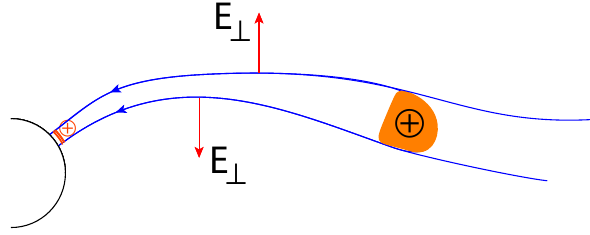
Fig. 5. A positive electromotive force in the outer magnetosphere enclosed between two field lines is experienced at all altitudes be- low it as an electric charge. The magnetic field lines behave as equipotentials thus mapping the electromotive difference between them down to the ionosphere where it possesses the same sign but acts like a positive space charge. This implies that the perpendicular electric field along the magnetic flux tube enclosed between the two field lines diverges which causes a shear motion in the surrounding plasma. In this way, the electromotive force in the ion-inertial Hall region is the source of shear motion along the flux tube and gener- ates the positive topside ionospheric potential and field aligned elec- tric field which extract the ionospheric electron component from the ionosphere and generates a downward field aligned